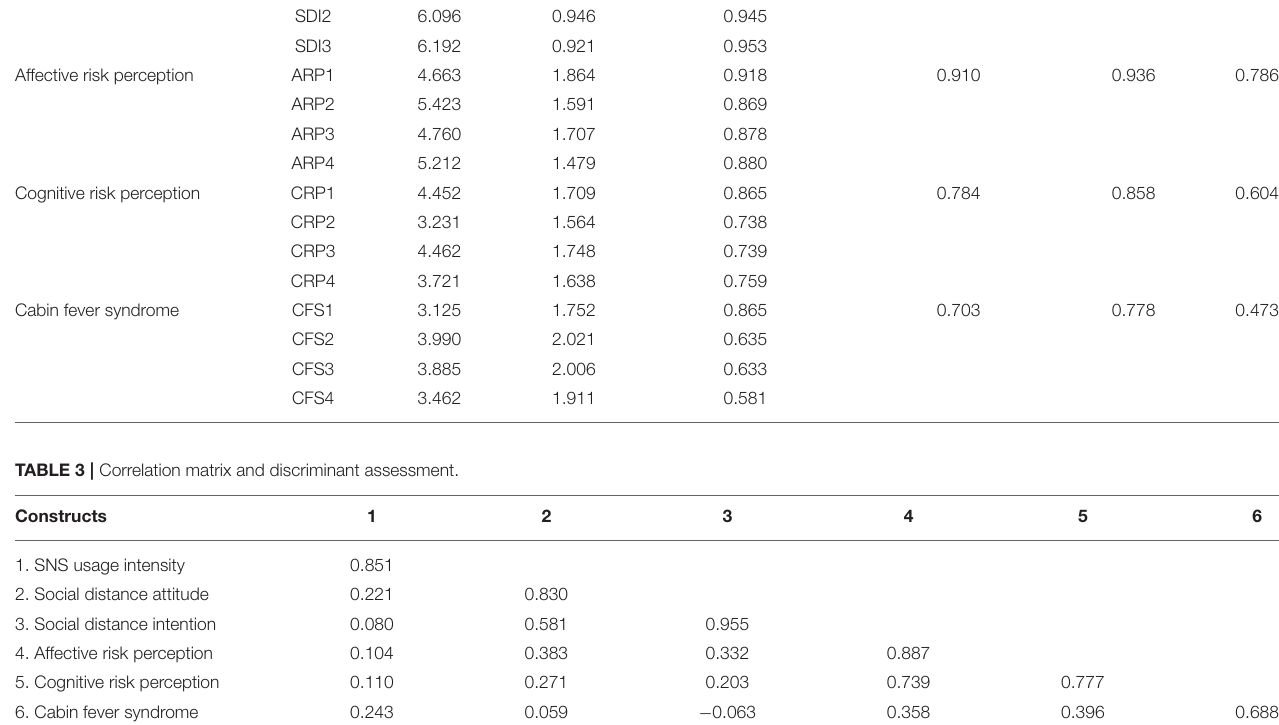
Diagonal values are the square root of AVE.